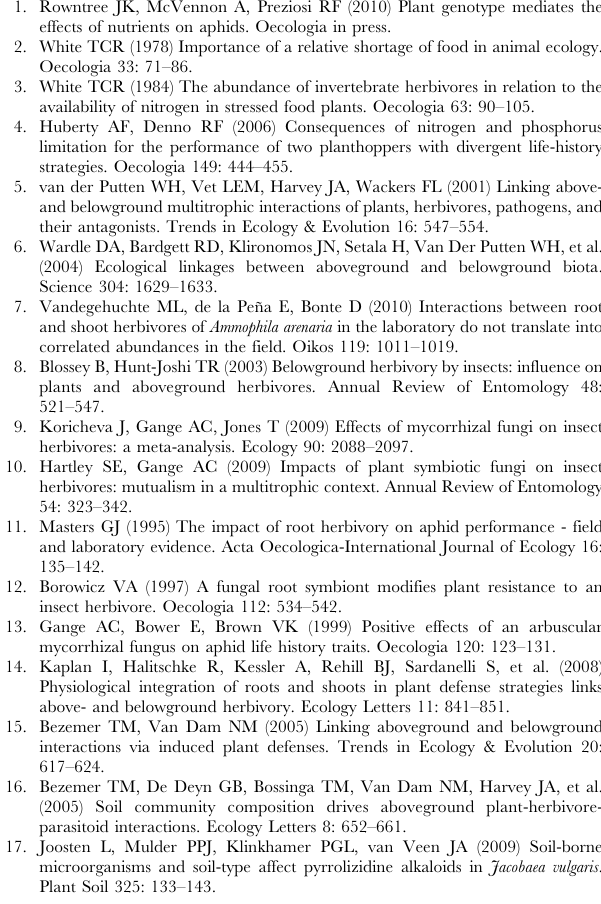
Table S3 Results of pairwise comparisons among levels of factors that significantly affected plant and aphid characteristics in the final permutational ANOVA models. Comparisons were made by means of permutational t-tests. When the number of unique permutations was lower than 100, Monte Carlo sampling was used to obtain reliable P-values. Region - PE: Le Perroquet, WE: Westhoek, TY: Ter Yde. Inoculum - /: no inoculum, d: dynamic dune biota, s: stabilised dune biota.